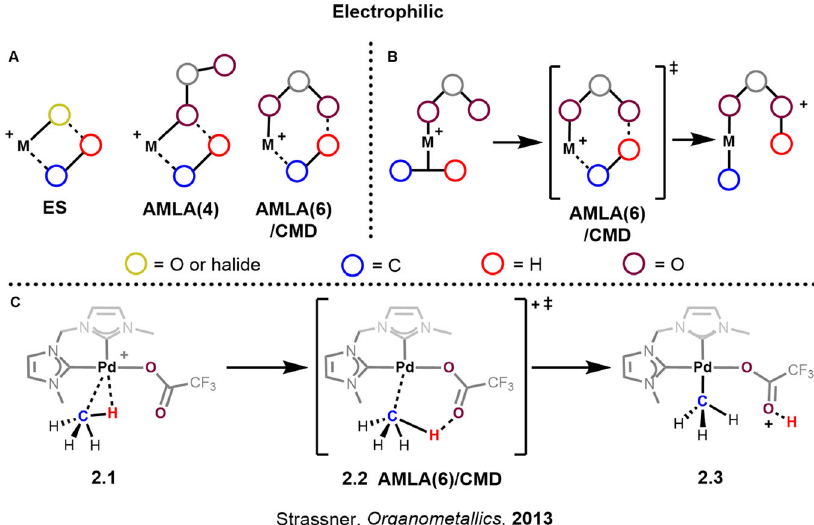
Fig. 3 Electrophilic mechanisms. A Three most common transition states are found in electrophilic C-H activation. B Simpli fi ed depiction of the AMLA(6)/ CMD mechanism. C DFT calculated mechanism for the C-H activation of methane at (NHC) 2 Pd(II) via the AMLA(6)/CMD transition